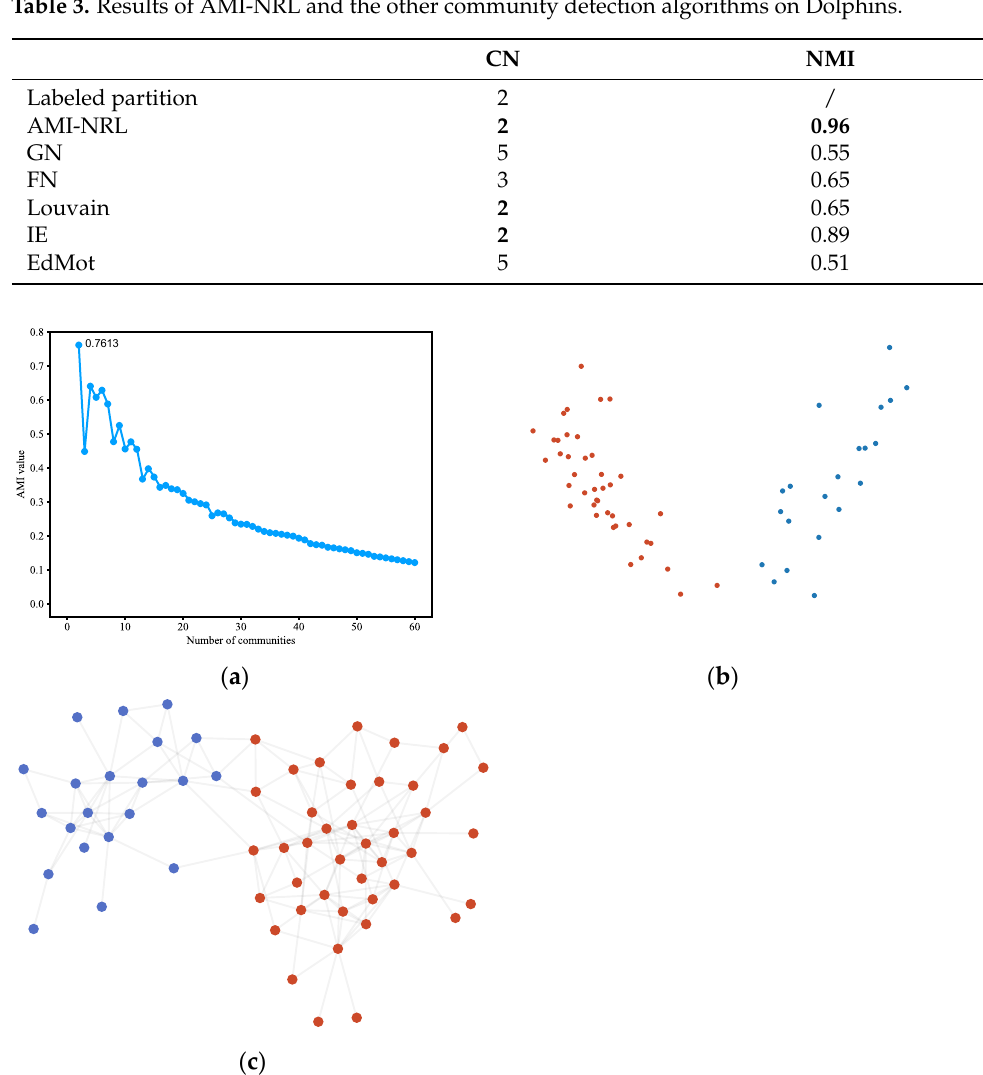
Table 3. Results of AMI-NRL and the other community detection algorithms on Dolphins.